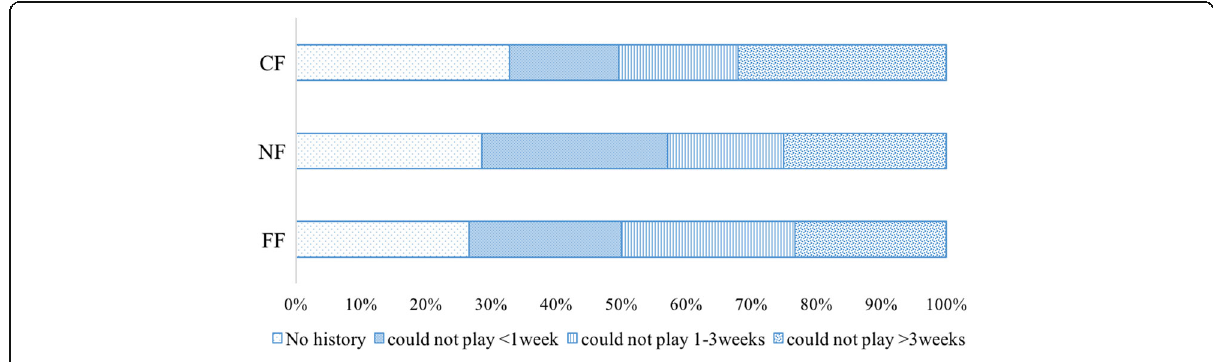
Fig. 8 Comparisons according to ankle sprain severity. There were no significant